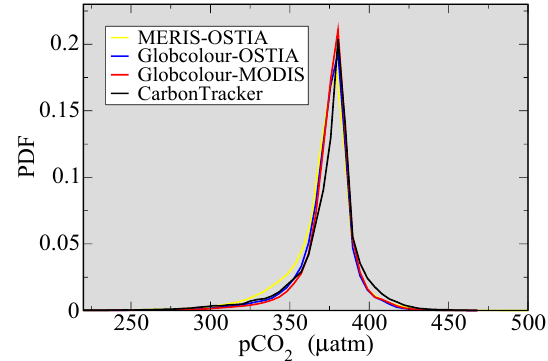
Figure 9. Comparison of the probability distribution functions of CarbonTracker and inferred p CO 2 values over the Benguela area for the three different SST and OC product combinations: MERIS Chl and OSTIA SST, GLOBCOLOUR merged Chl and OSTIA SST, and GLOBCOLOUR merged Chl and MODIS